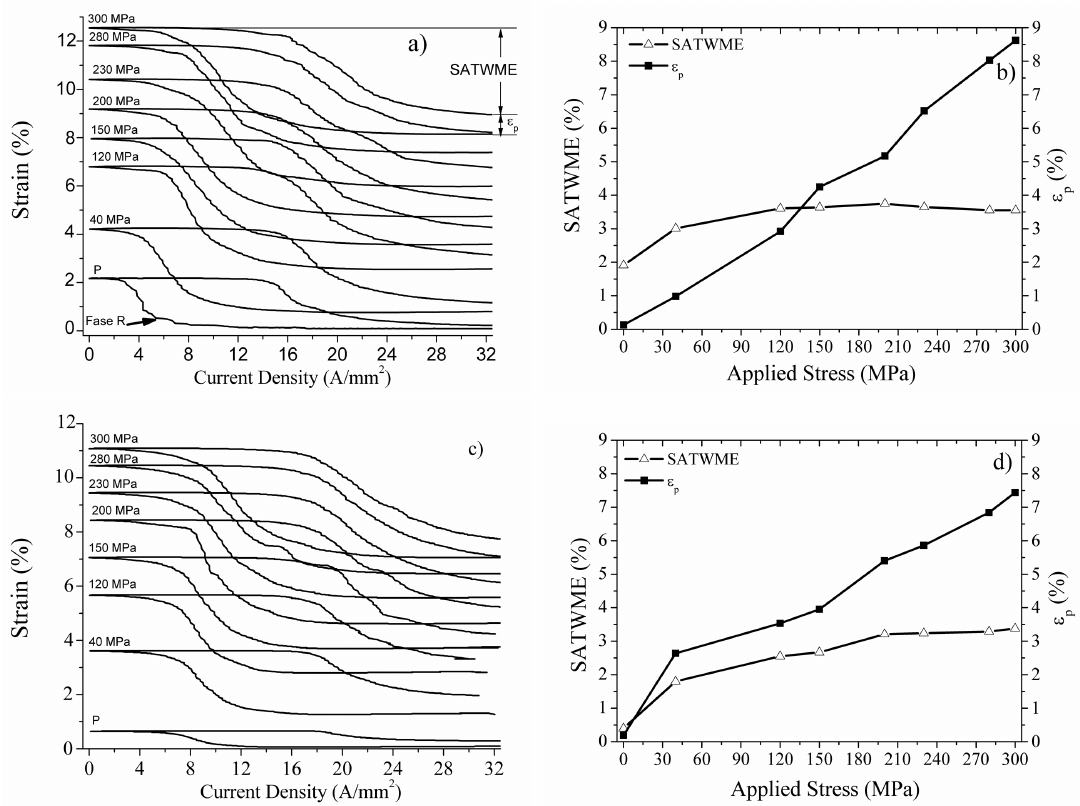
Figure 3. Strain-Current Density during thermal cycles under different constant stresses for M2 ribbons processed at 50 m/s, a) as-spun, c) annealed at HT-1, b) and d) show SATWME (open symbols) versus plastic deformation (filled symbols) for as-spun and annealed